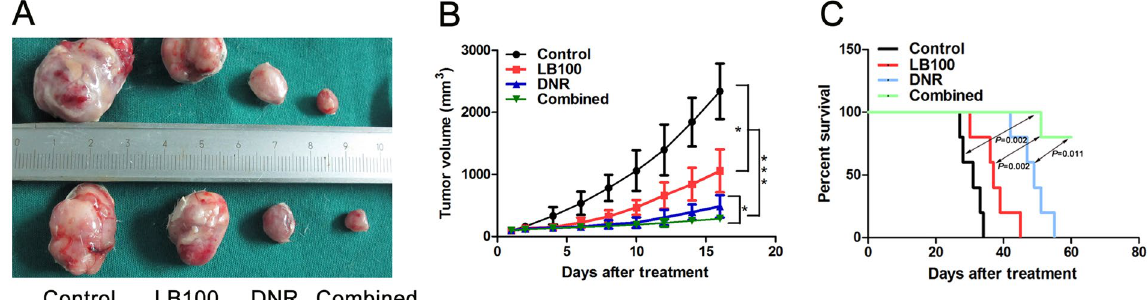
Figure 4. LB100 in combination with daunorubicin significantly decreases tumor burden in vivo . ( A , B ) Tumor volume was significantly lower in mice receiving LB100 ( P = 0.017) or Daunorubicin monotherapy ( P < 0.001) as compared to control. Further benefit was seen with combination daunorubicin + LB100 therapy as compared to mice receiving either monotherapy, or control. ( C ) A significant improvement in overall survival was observed with daunorubicin + LB100 therapy versus control ( P = 0.002), versus daunorubicin monotherapy ( P = 0.011), and versus LB100 monotherapy ( P = 0.002). Statistically significant differences are marked by an asterisk ( * P < 0.05; *** P ≤ 0.001).